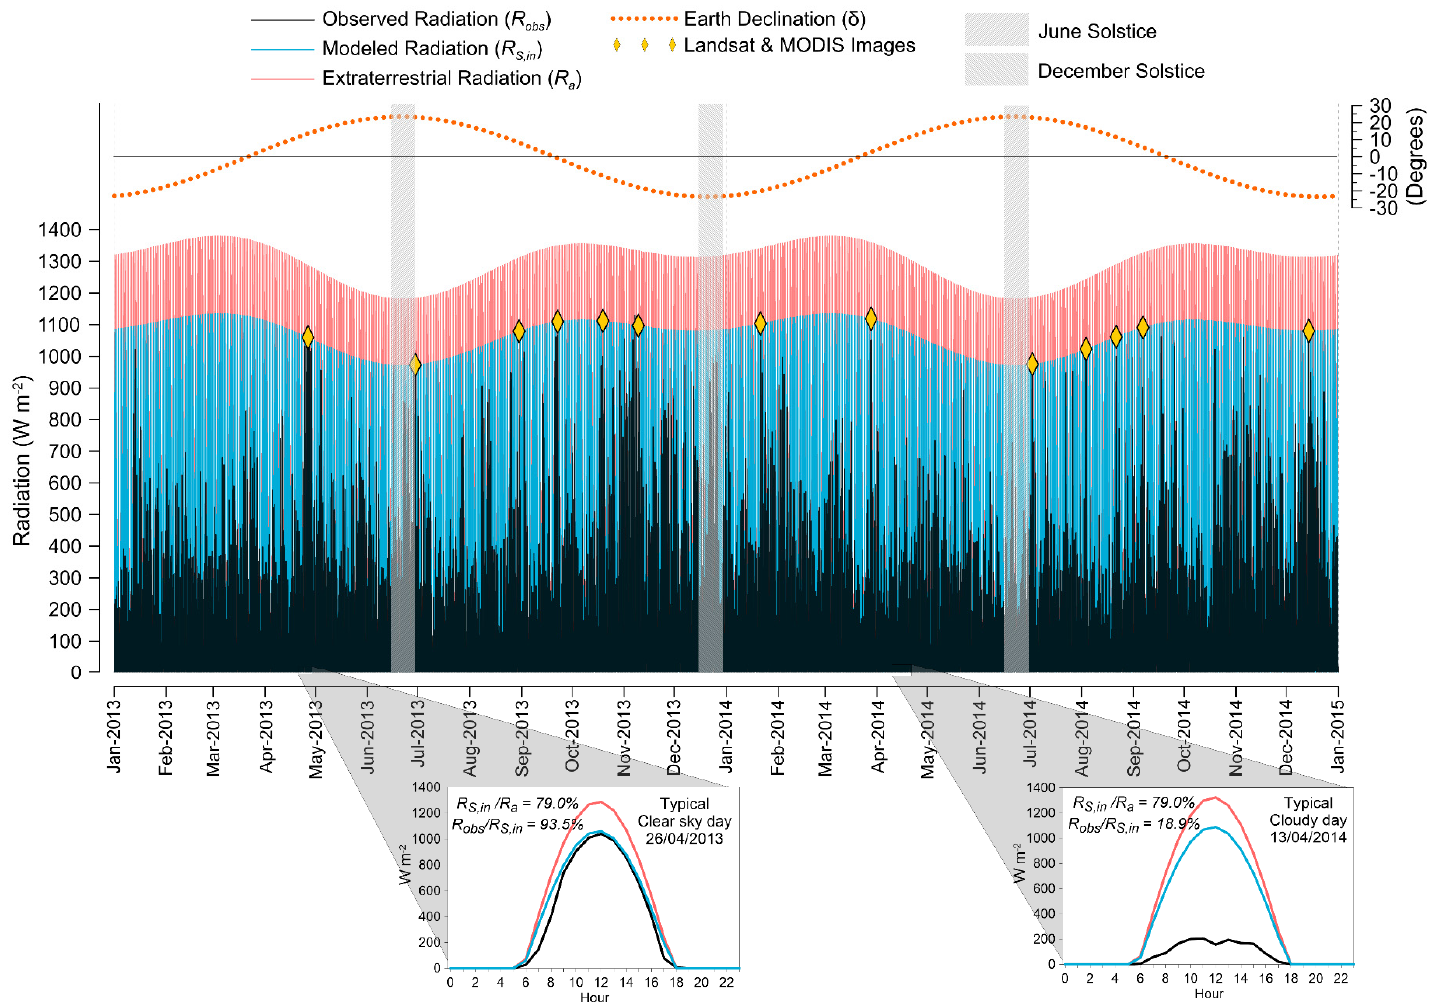
Figure 7. Modeled and observed radiation for 2013–2014 (hourly means of the three AWSs) and Earth declination angle.